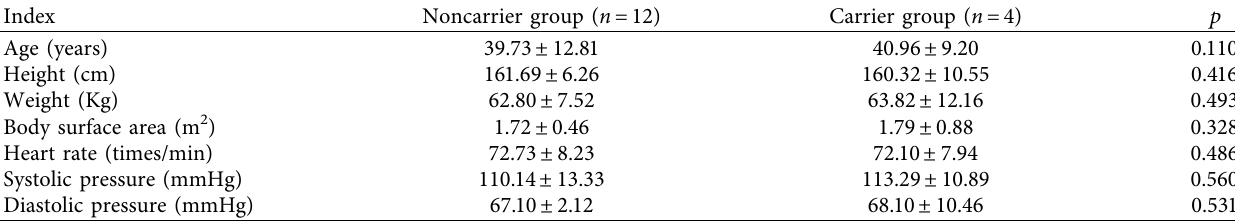
Table 1: Comparison of general clinical data between the two groups ( x ± s ).